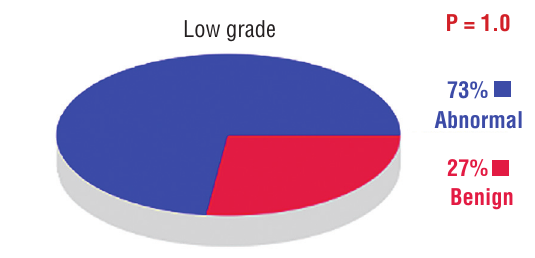
Figure 1 - UTC and tumor grade.